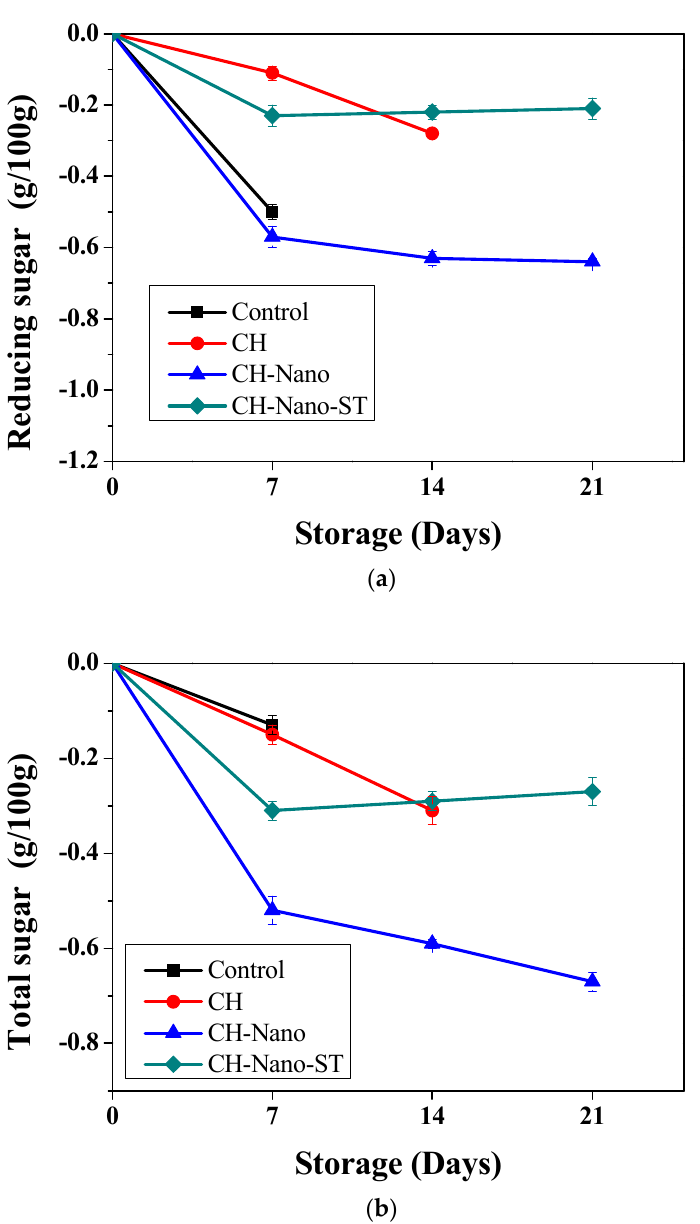
Figure 3. Effect of coating treatments of cucumber sampleson reducing sugar ( a ), and total sugar contents ( b ).